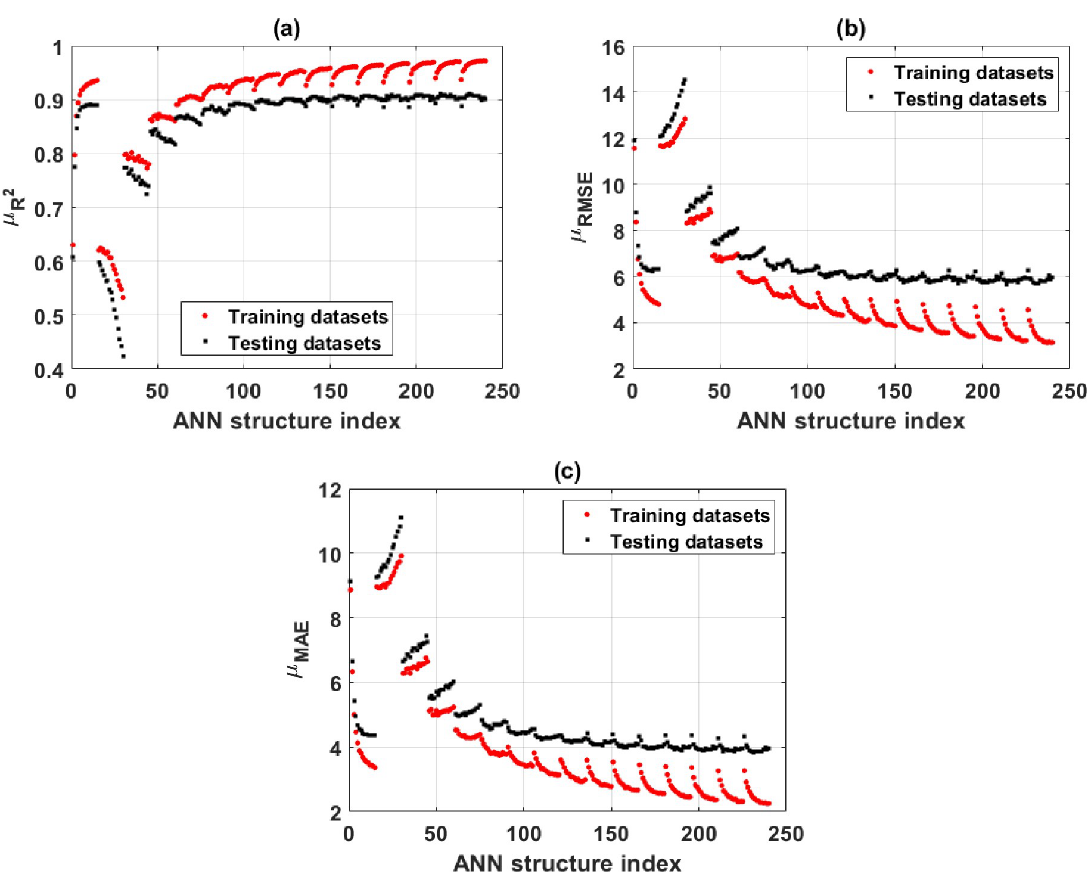
Fig 5. Performance of the ANN as a function of neuron count in two hidden layers, as measured by (a) mean R 2 for the training and testing parts; (b) mean RMSE for the training and testing parts; and (c) mean MAE for the training and testing parts.